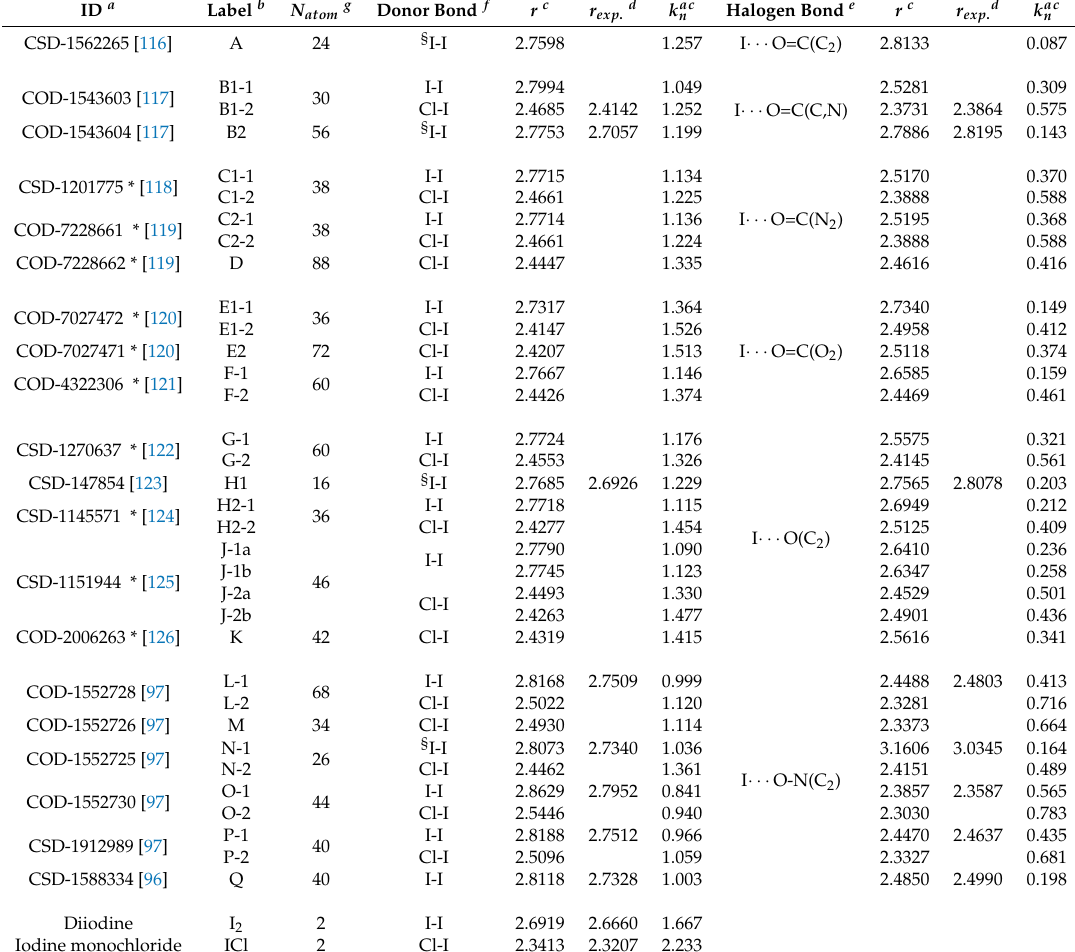
Table 1. Summary of 34 X-I · · · O halogen bonding interactions investigated in this